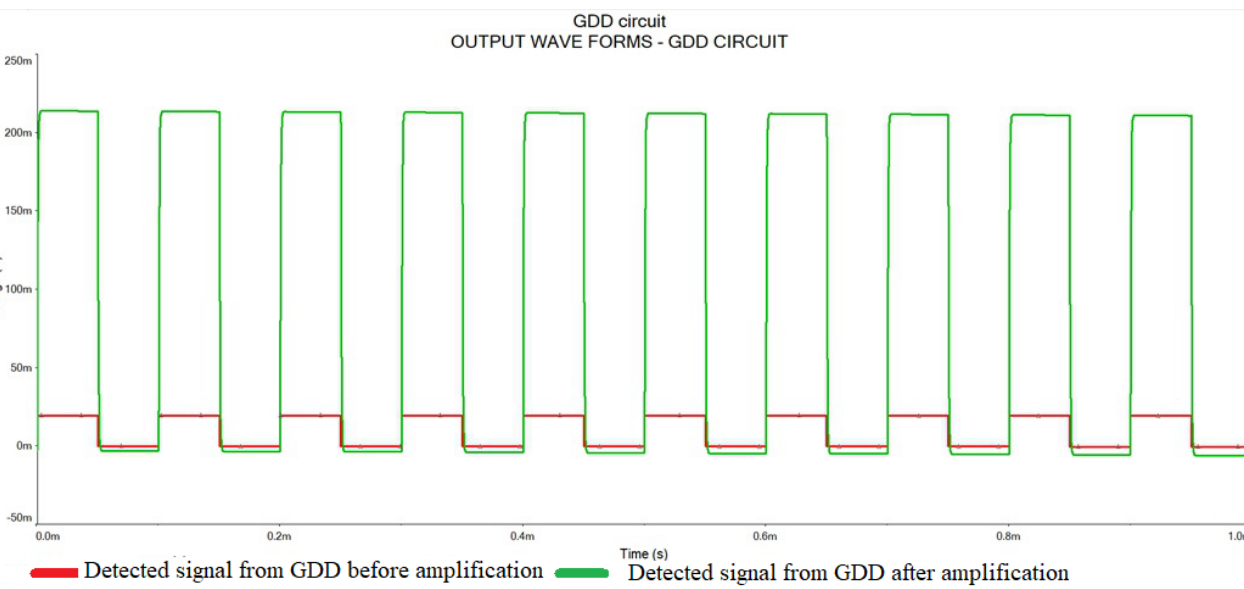
Figure 5. Output waveform from an individual GDD in the row detector circuit before amplification, and after amplification.